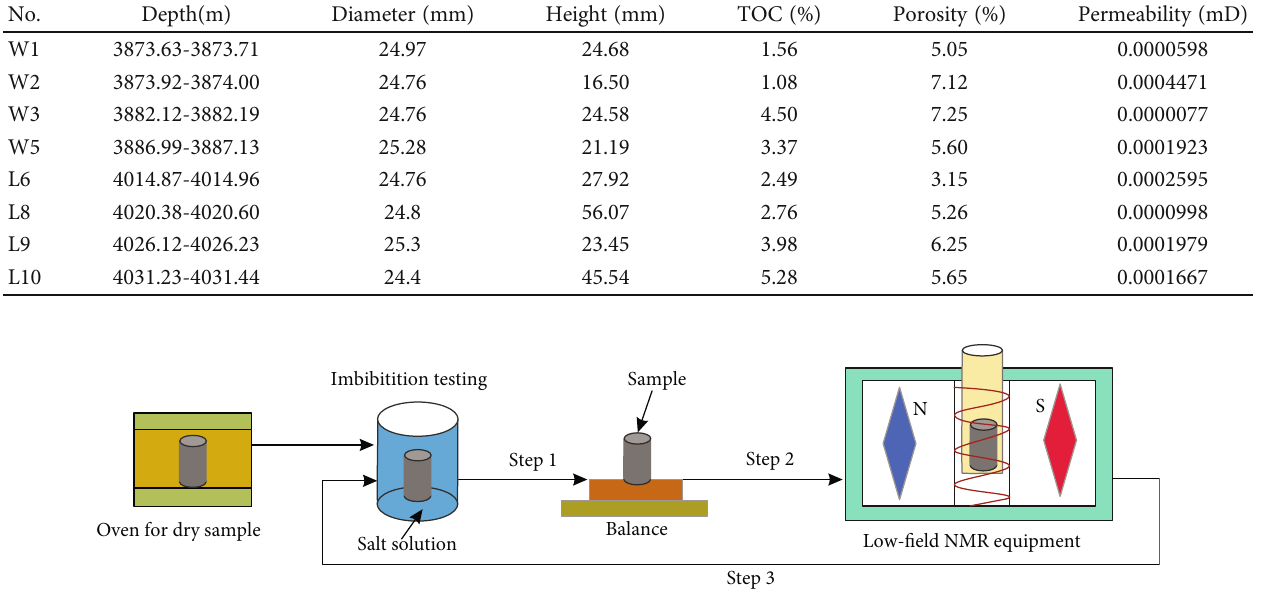
Figure 1: The experimental process of shale sample spontaneous imbibition and NMR. Table 2: Spontaneous imbibition curve parameters of the deep Longmaxi Formation shale